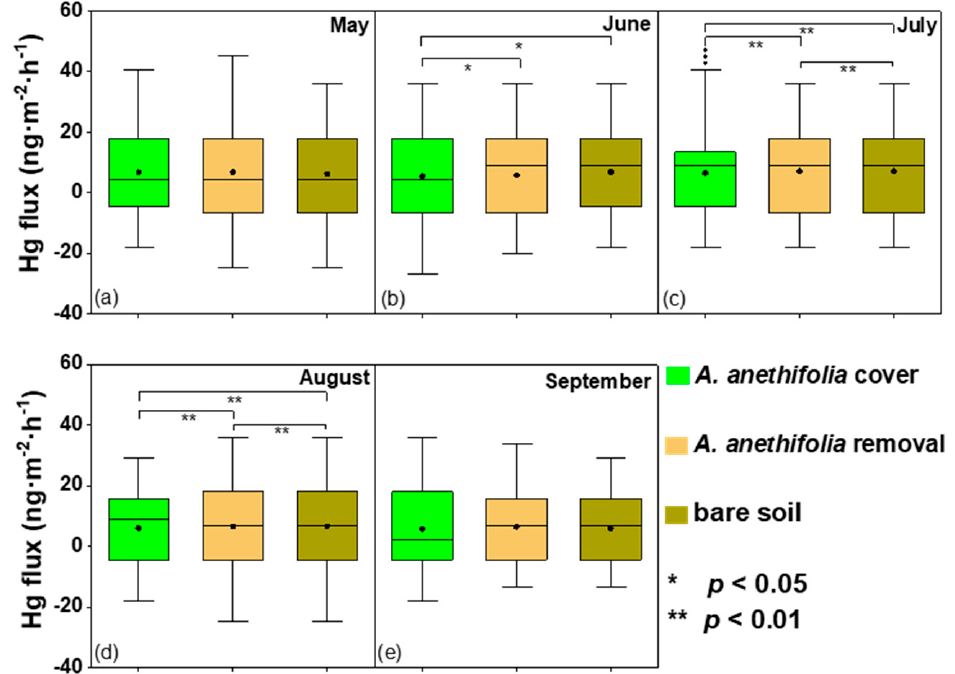
Figure 3. Box plots of the soil-air Hg exchange fluxes for the three examined conditions ( Artemisia anethifolia coverage, Artemisia anethifolia removal, and bare soil) from May to September 2018. *: In the figure, the asterisk represents a significantly different flux compared to the other plots during the same season; sub figure ( a – e ) represents May to September 2018; * p < 0.05; ** p < 0.01